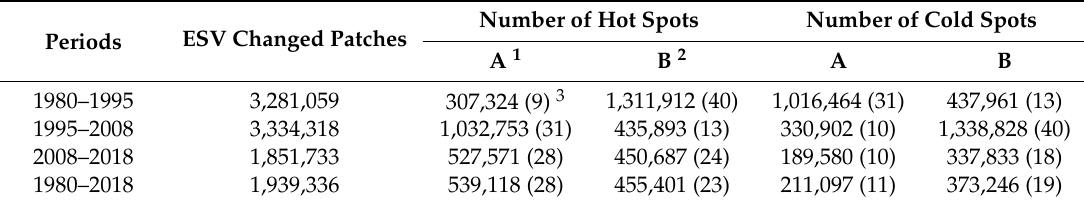
Table 7. Statistics for hotspots and cold spots of ESV increases at a confidence level of 95% in the HXNR during 1980–2018. Number of Hot Periods ESV Changed Patches